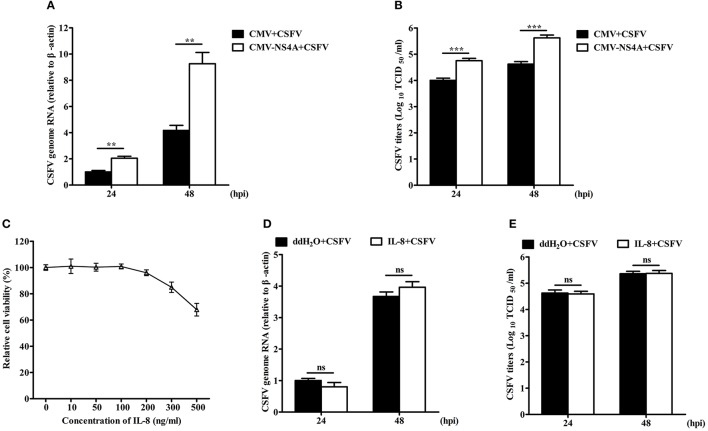
NS4A promotes CSFV propagation. (A,B) CSFV propagation in NS4A-transfected SUVECs. SUVECs were transfected with CMV-NS4A. At 12 hpt, cells were infected with CSFV at an MOI of 0.1 for 24 and 48 h. Cells were collected and CSFV genome RNA was determined by real-time PCR. The supernatants were collected and the extracellular viral titers were detected and expressed as TCID50/mL at 24 and 48 hpi. (C) The cell viability upon the treatment of IL-8. SUVECs were treated with different concentrations of IL-8 for 48 h and the cell viability was measured by the CCK-8 assay. (D,E) CSFV propagation in IL-8-treated SUVECs. SUVECs were infected with CSFV at an MOI of 0.1 and maintained in media with IL-8 (100 ng/mL). Then CSFV genome RNA and extracellular viral titers were determined by real-time PCR and IFA. Error bars represent the mean ± SD (n = 3). **P < 0.01; ***P < 0.001; ns (no significant), P > 0.05.